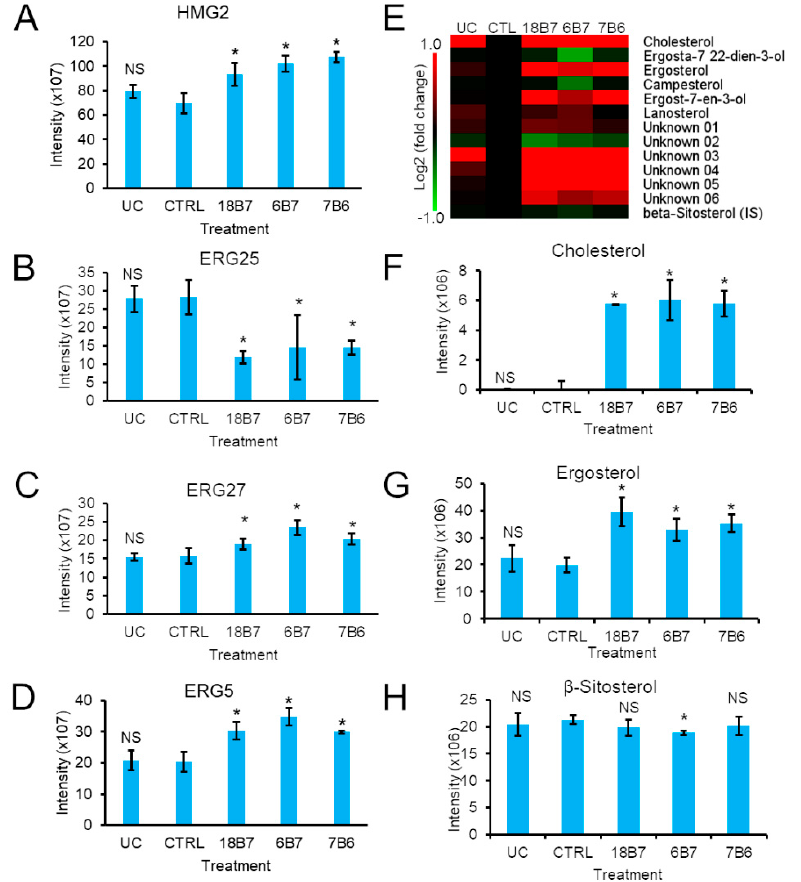
Figure 5. Effect of monoclonal antibodies on the H. capsulatum sterol metabolism. ( A-D ) Abundance profiles of ergosterol biosynthetic enzymes: ( A ) 3-hydroxy-3-methylglutaryl coenzyme A reductase HMG2, ( B ) C-4 methylsterol oxidase ERG25, ( C ) 3-ketosteroid reductase ERG27 and ( D ) cytochrome P450 sterol C-22 desaturase ERG5. ( E ) Heatmap of the sterol species. ( F-G ) Abundance profiles of sterols H. capsulatum cells treated with monoclonal antibodies: ( F ) cholesterol, ( G ) ergosterol and ( H ) β -sitosterol (internal standard). Abbreviations: CTRL, control; UC, untreated control without hybridoma medium. t -test: NS, not significant; * p ≤ 0.05 compared to the control sample.